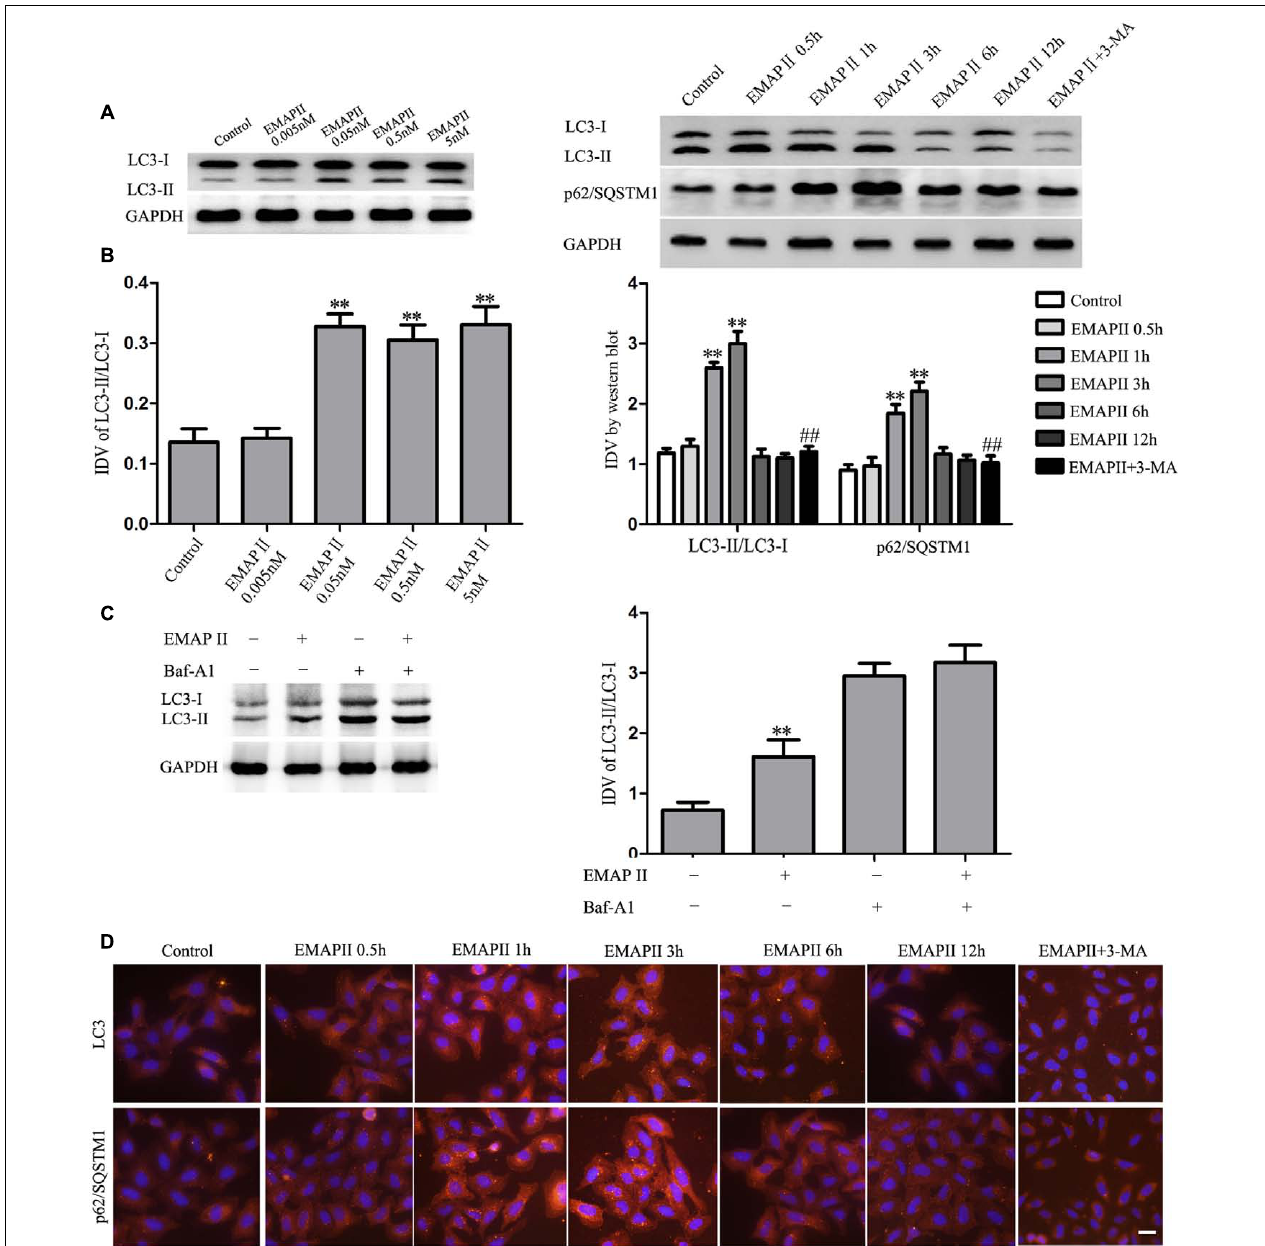
FIGURE 3 | Effect of EMAP II on the expression and distribution of LC3 and p62/SQSTM1 in GECs. (A) Western blot assay to evaluate the effect of 0.005, 0.05, 0.5, and 5 nM EMAP II for 3 h on the expression of LC3-II/LC3-I in GECs. (B) Western blot assay to evaluate the effect of 0.05 nM EMAP II for 0.5, 1, 3, 6, and 12 h and 3-MA on the expression of LC3-II/LC3-I and p62/SQSTM1 in GECs. Data represent means ± SD ( n = 5, each). ∗∗ P < 0.01 vs. control group, ## P < 0.01 vs. EMAP II group. (C) GECs were treated with 0.05 nM EMAP II for 3 h in the presence of Baf-A1 (50 nM), and LC3-II level was evaluated by Western blot analysis. Data represent means ± SD ( n = 5, each). ∗∗ P < 0.01 vs. EMAP II ( − ) + Baf-A1 ( − )group. (D) Immunofluorescence staining of LC3 and p62/SQSTM1 in GECs after 0.05 nM EMAP II treatment for 0.5, 1, 3, 6, and 12 h and 3-MA. Nuclei were labeled with DAPI. Images are representative of independent experiments ( n = 4). Scale bars represent 20 µ